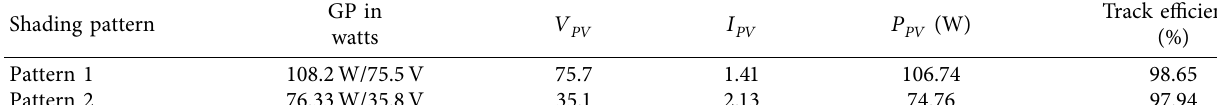
Table 3: Performance comparison of the proposed GWO-ANFIS MPPT method for 4S confguration. GP in Shading pattern watts Pattern 1 Pattern 2